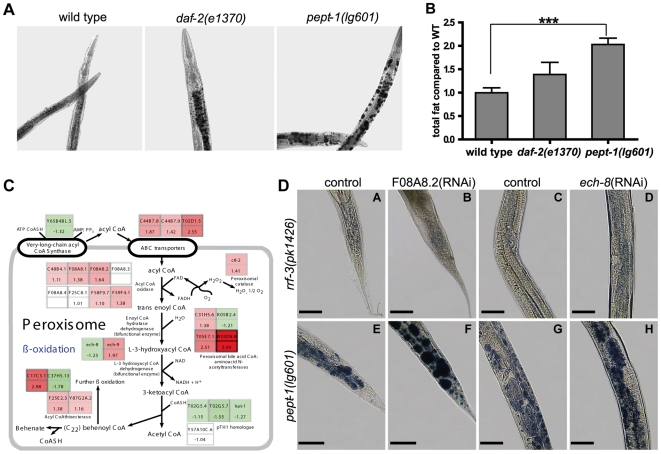
Body fat content in wild type, daf-2(e1370) and pept-1(lg601) C. elegans.(A) The worms were stained with Sudan Black to visualize the body fat. In each image, the anterior end is positioned to the top. (B) Total fat in comparison to wild type (set to one) was calculated based on gas chromatographic measurements. (C) Changes in mRNA expression of genes involved in peroxisomal β-oxidation of fatty acid metabolism in pept-1(lg601) C. elegans. The data are based on microarray analysis data in comparison to wild type (n = 5). Genes expressed in low levels in pept-1(lg601) are highlighted in green boxes, and genes expressed in higher levels are highlighted in red boxes. The darker the color, the higher is the change in expression. Genes with changes in expression<0.1 are not colored. (D) Impact of peroxisomal β-oxidation on the body fat content in rrf-3(pk1426) and pept-1(lg601) C. elegans. RNAi knockdown of F08A8.2 (coding for acyl CoA oxidase) had no effects on the body fat in rrf-3 (A, B) but increased the total body fat in pept-1(lg601) leading to extremely large fat droplets in the posterior part of the worms (E, F). Knockdown of ech-8 (coding for peroxisomal bifunctional enzyme hydroxyacyl-CoA dehydrogenase/enoyl-CoA hydratase) slightly increased the body fat in rrf-3 when compared to control rrf-3 (C, D). The effect was more pronounced in a pept-1(lg601) background (G, H). The body fat was detected by Sudan Black staining. Scales indicate 50 µm.